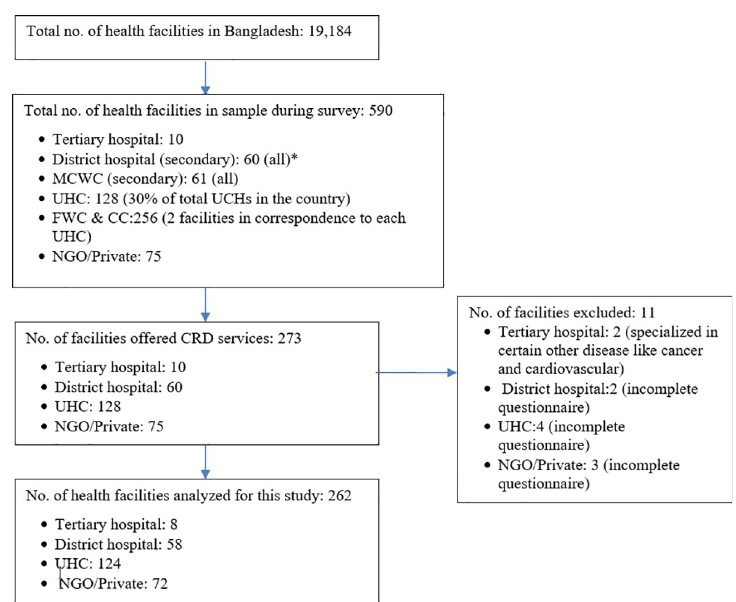
Fig 1. Sampling and study inclusion flow chart. N > B- UHC: Upazila Health Complex, MCWC: Maternal and Child Welfare Center, FWC: Family Welfare Center, CC: Community Clinic, NGO: Non Government Organization. � rest of the district hospitals had been converted to medical college hospital (tertiary